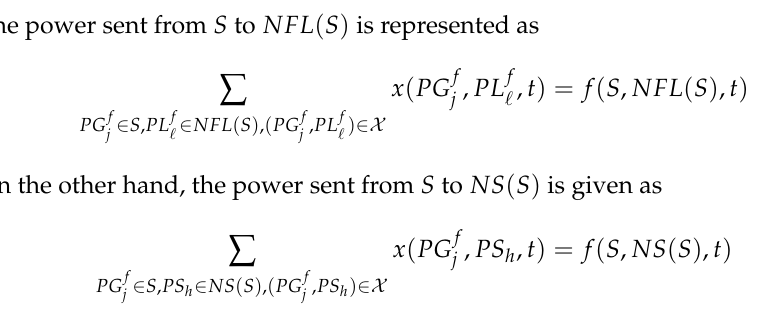
Figure 7. Subset S of power generators and the neighbor connected set of power